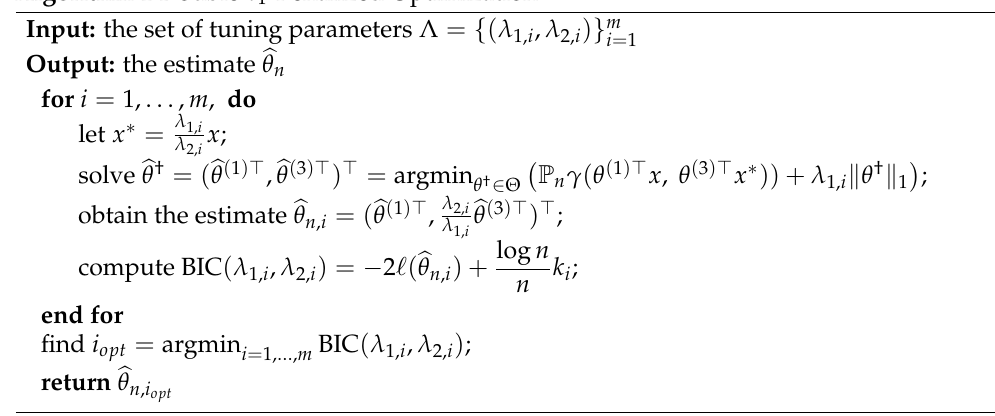
Algorithm 1 Double (cid:96) 1 -Penalized